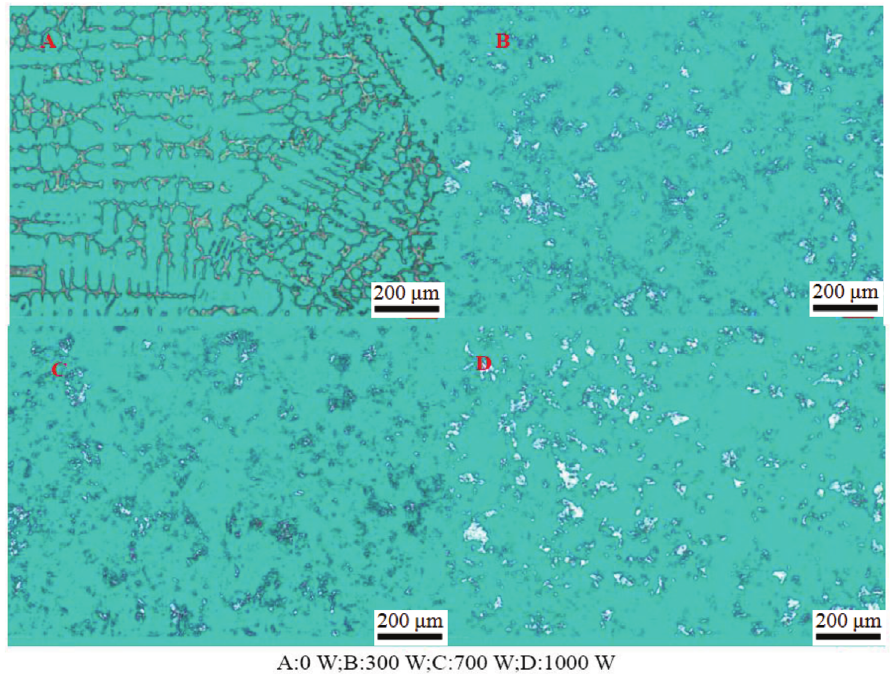
Figure 8: Carbide distribution of GCr15 steel with different ultrasonic